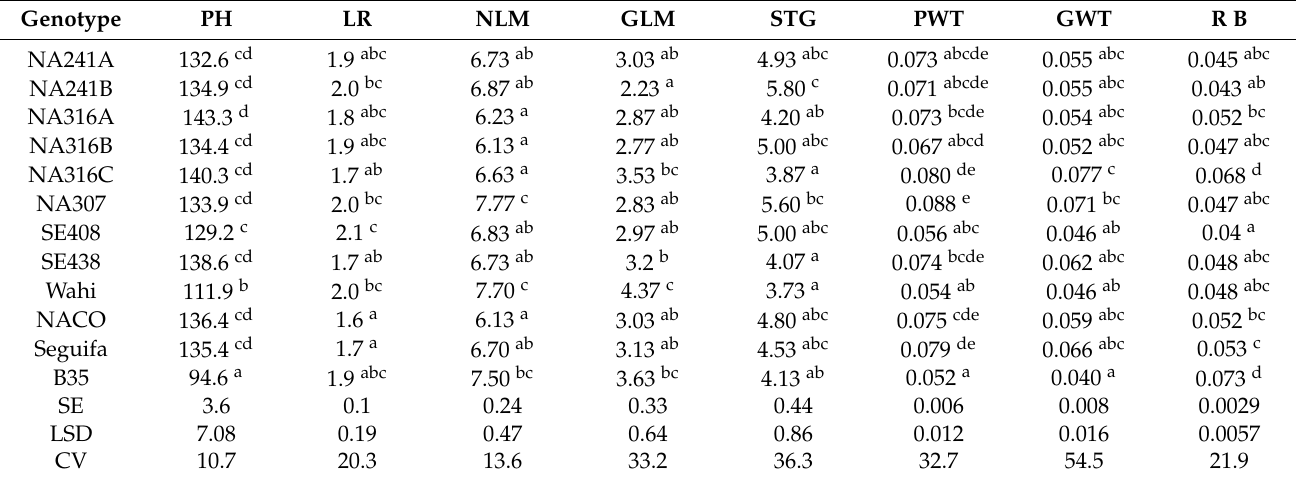
Table 5. Means of trait performance for sorghum genotypes under well-watered conditions.